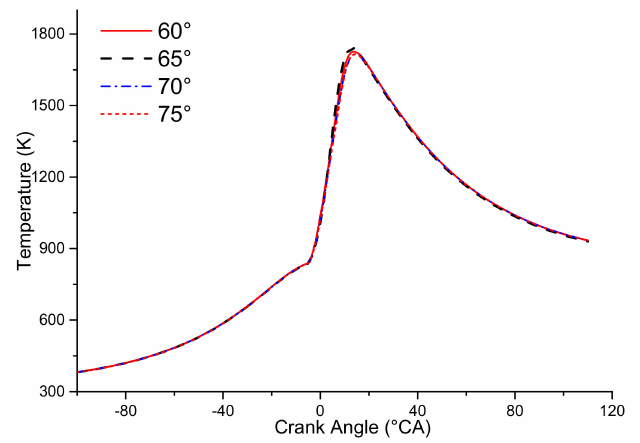
Figure 18. Mean in-cylinder temperature at di ff erent PCC nozzle angles.